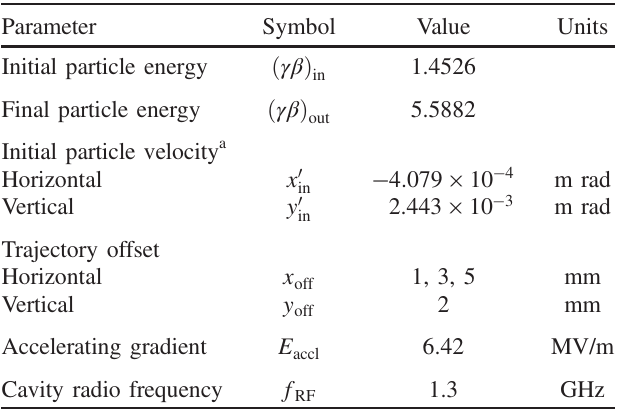
TABLE V. Parameters of test